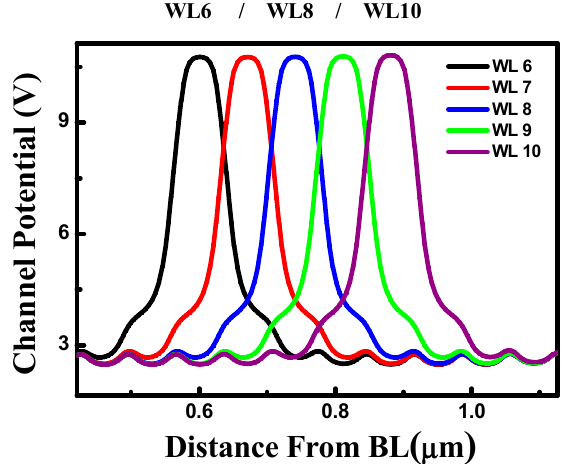
Figure 3. NLSB that occurs for each WL generated in the middle cell (WL11 through WL15).